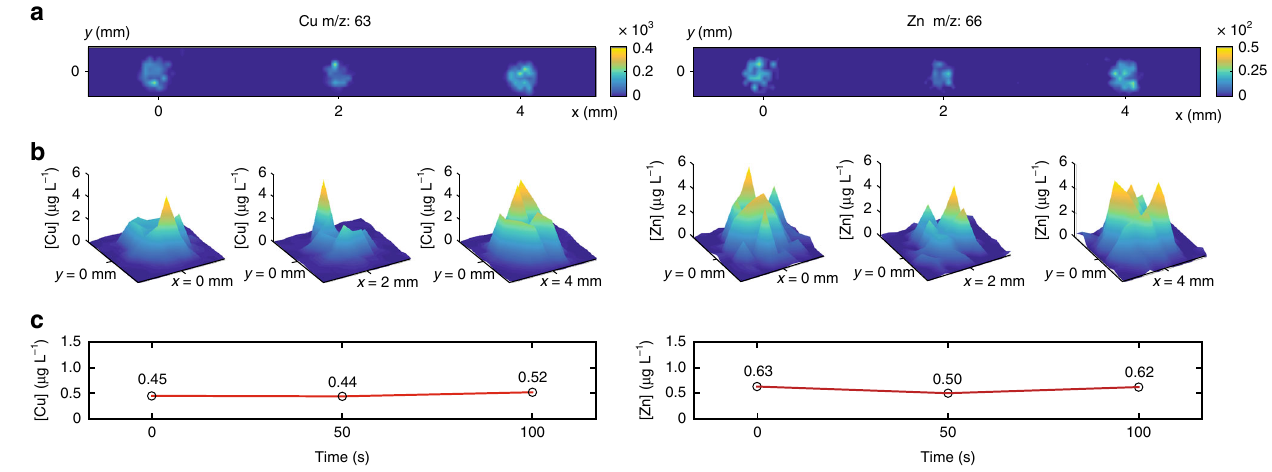
Fig. 4 Time evolution of the trace metal concentration found in the brain- fl uid samples re fl ecting the brain neurochemical state. a Trace metal relative abundance for Cu and Zn for three successive droplets. b 3D plots of Cu and Zn spatial concentration for each brain- fl uid samples. The vertical axis is proportional to the concentration. c Temporal evolution of the concentration found in brain- fl uid samples (sampling interval is 50 s)